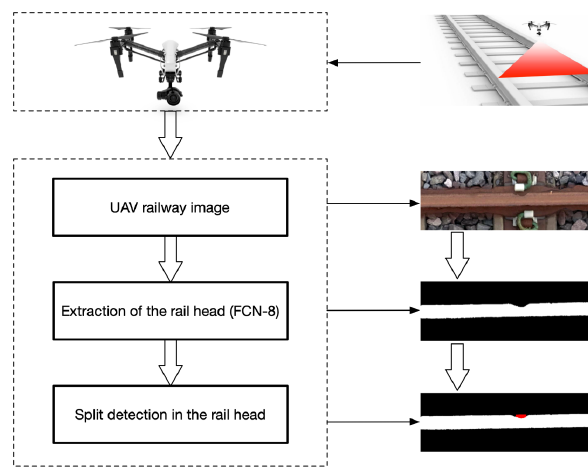
Figure 2: Structure of the presented algorithm for split defect detec-